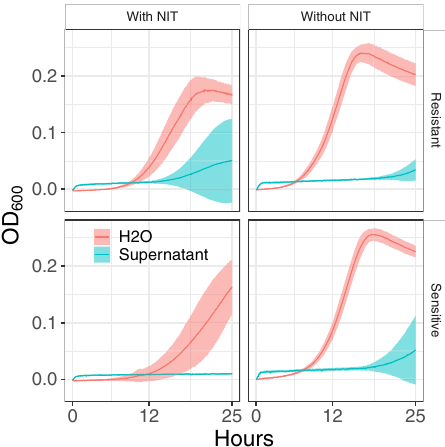
Fig. 4 B. subtilis supernatant inhibits E. coli growth in minimal media. Growth of NIT S and NIT R E. coli depicted as change in OD 600 over 24 h in minimal media diluted with either sterile water or cell-free supernatant from B. subtilis . Each line is an average from three independent biological replicates. Error bars, shown as ribbons, represent 95% con fi dence intervals ( t- distribution, n = 3).